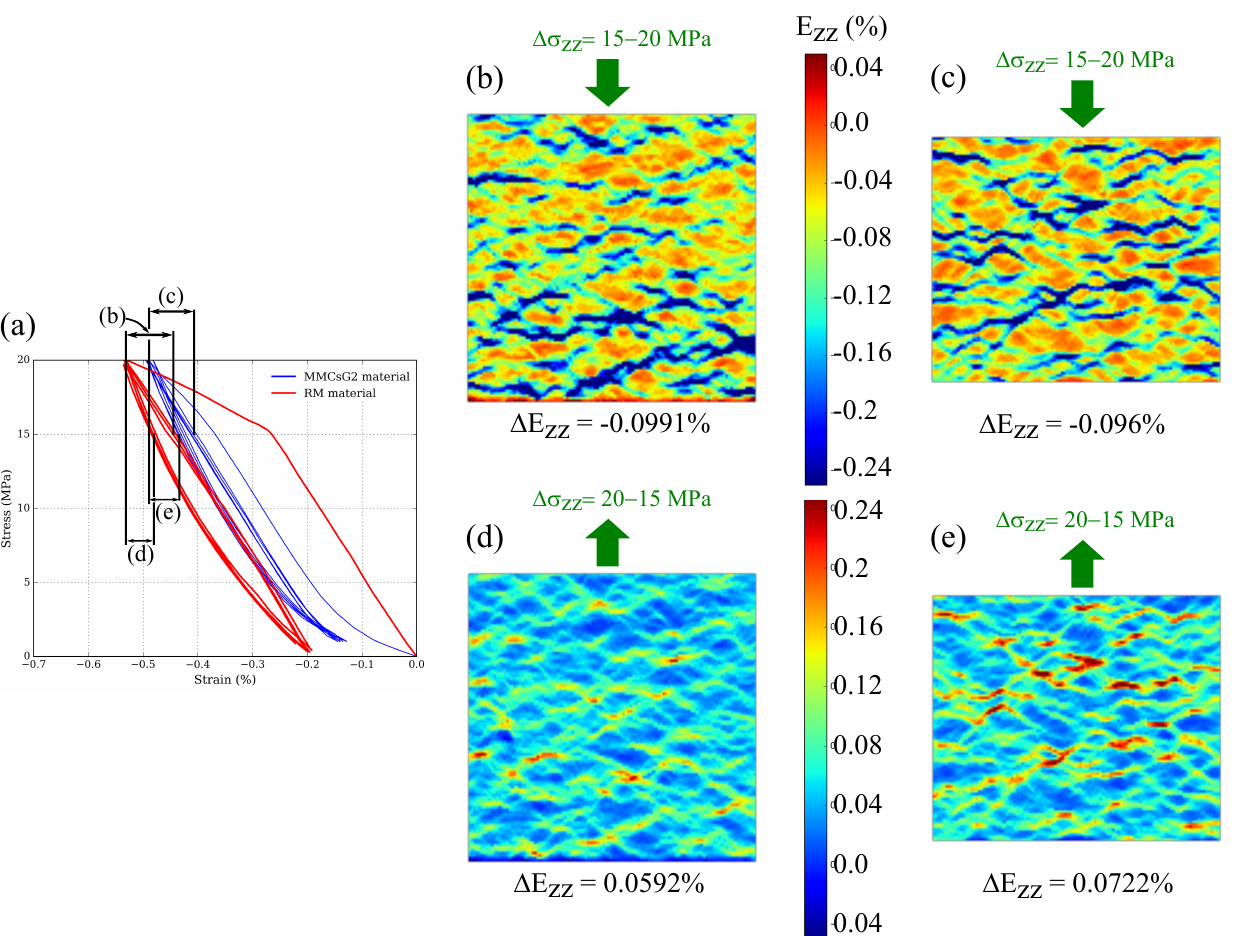
Figure 9. ( a ) Compressive stress-strain (E zz ) curves of RM and MMCsG2 materials, where ∆ σ = 15–20 MPa and ∆ σ = 20–15 MPa elastic intervals are indicated with black arrows. ( b ) DIC E zz image of the RM corresponding to the ∆ σ = 15–20 MPa loading within the loops. ( c ) DIC E zz image of the MMCsG2 material corresponding to the ∆ σ = 15–20 MPa loading. ( d ) DIC E zz image of the RM corresponding to the ∆ σ = 20–15 MPa unloading. ( e ) DIC E zz image of the MMCsG2 material corresponding to the ∆ σ = 20–15 MPa